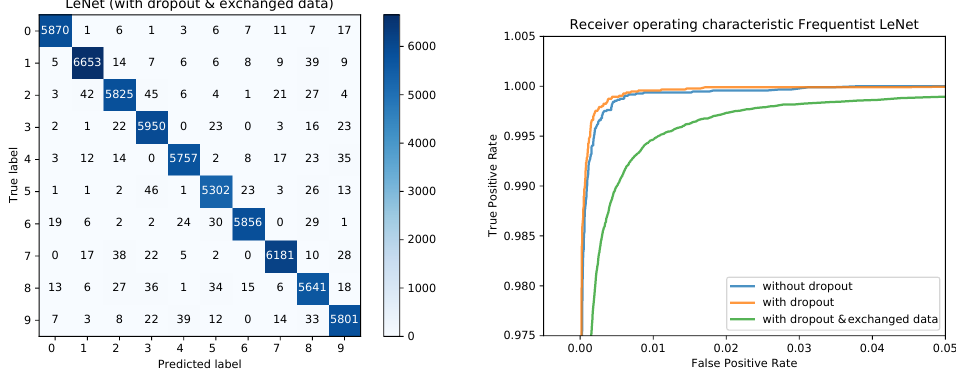
Figure 3. Confusion matrix for the frequentist LeNet with dropout and exchanged data and ROC curves for all three models.